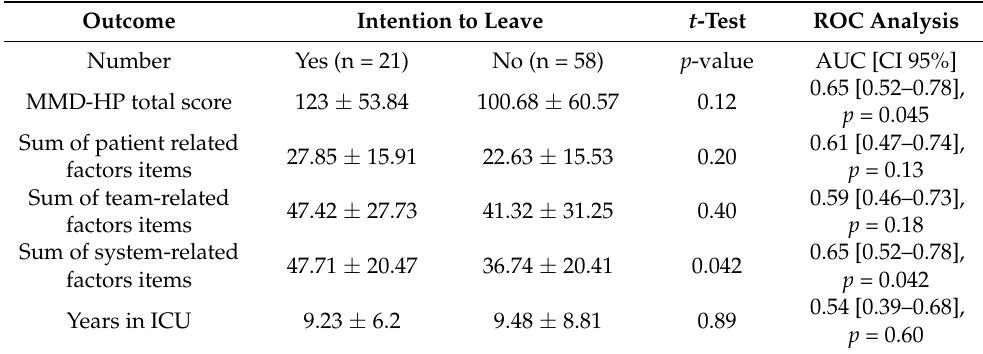
Table 3. Mean values for MMD-HP score and subscales, as well as experience of ICU work in nurses presenting a current intention to leave or not.